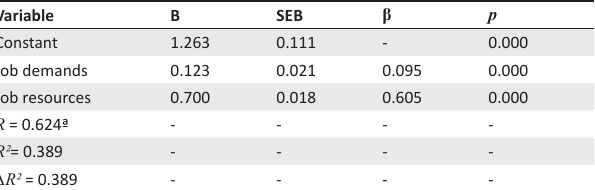
TABLE 5: Results of regression analysis in predicting work-based identity by job demands and job resources work-engagement by job demands and job resources.